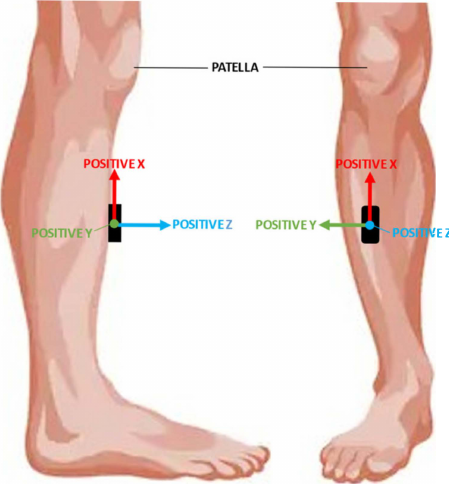
Figure 3. Placement and direction of the axes of the Ax6 sensor. After the stumbling trials, the participants performed several Activities of Daily Living (ADLs) that resemble common movements that are present in the daily life of